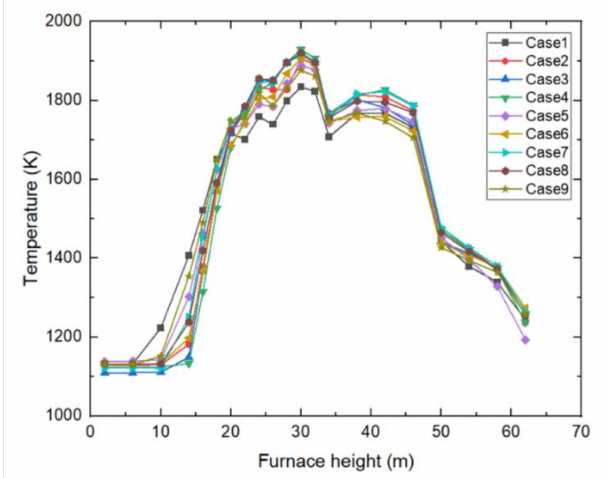
Figure 6. Temperature distribution in furnace height direction under various